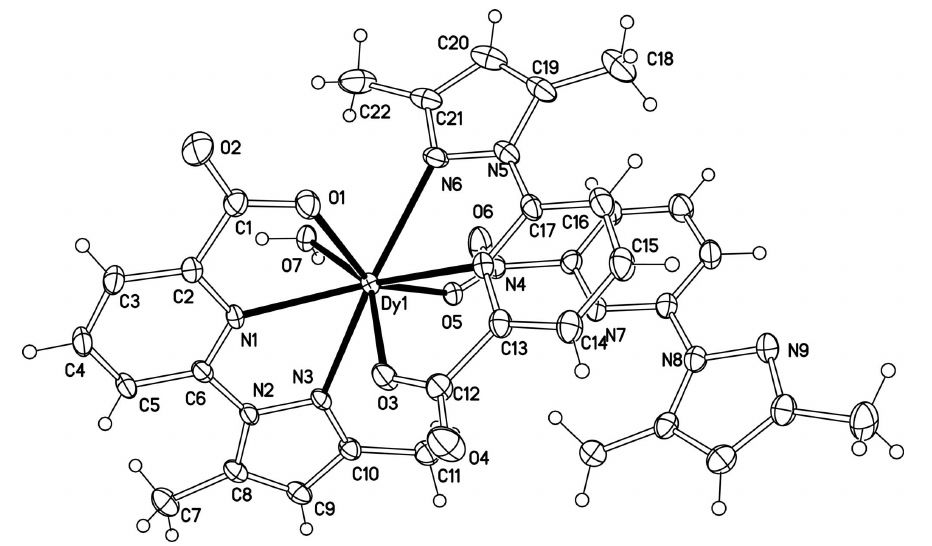
Figure 1 The molecular structure of the title compound showing 50% probability displacement ellipsoids and the atom-numbering scheme.